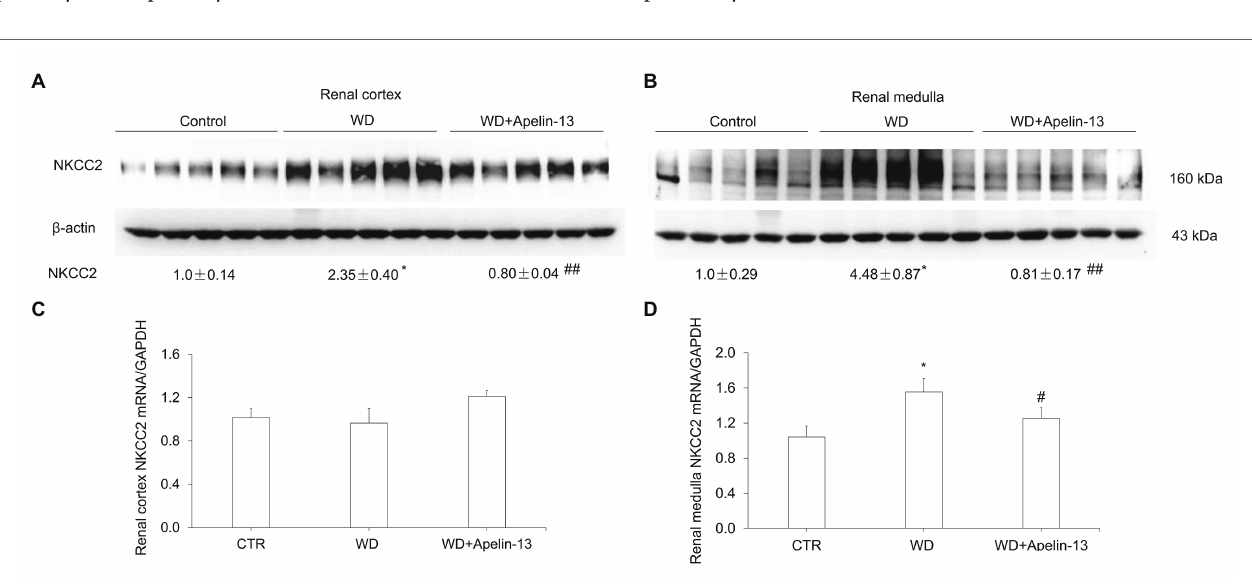
FIGURE 3 | Effect of apelin-13 on NKCC2 expression in the renal cortex and medulla in WD mice. (A,B) Representative immunoblotting and densitometric analysis of NKCC2 protein expression in the kidney cortex (A) and medulla (B) , the protein abundances were normalized by β -actin. (C,D) qRT-PCR analysis of renal NKCC2 mRNA expression in the kidney cortex (C) and medulla (D) , expression was normalized by GAPDH . n = 4–5 per group. Data are mean ± SEM. * p < 0.05 and ** p < 0.01 vs. Control; # p < 0.05 and ## p < 0.01 vs.